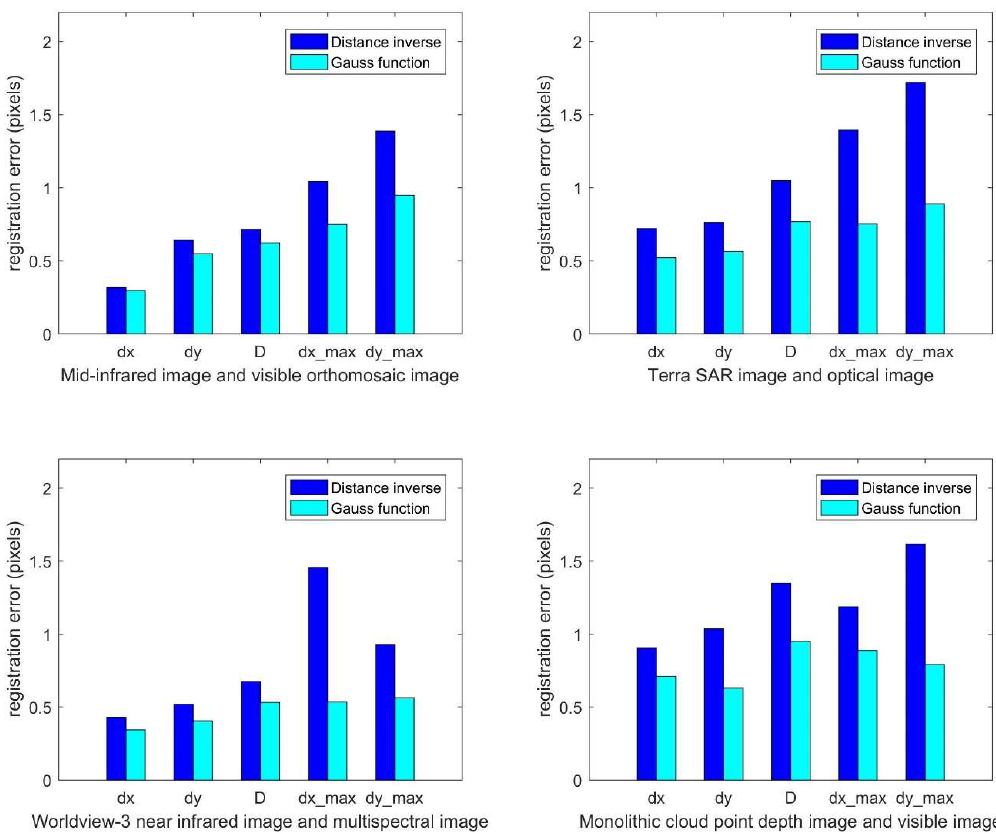
Figure 11 . Accuracy improvements from spatial weighting function in four multimodal datasets. Table 6. Quantitative evaluation comparison with the different spatial weighting function η in four multimodal